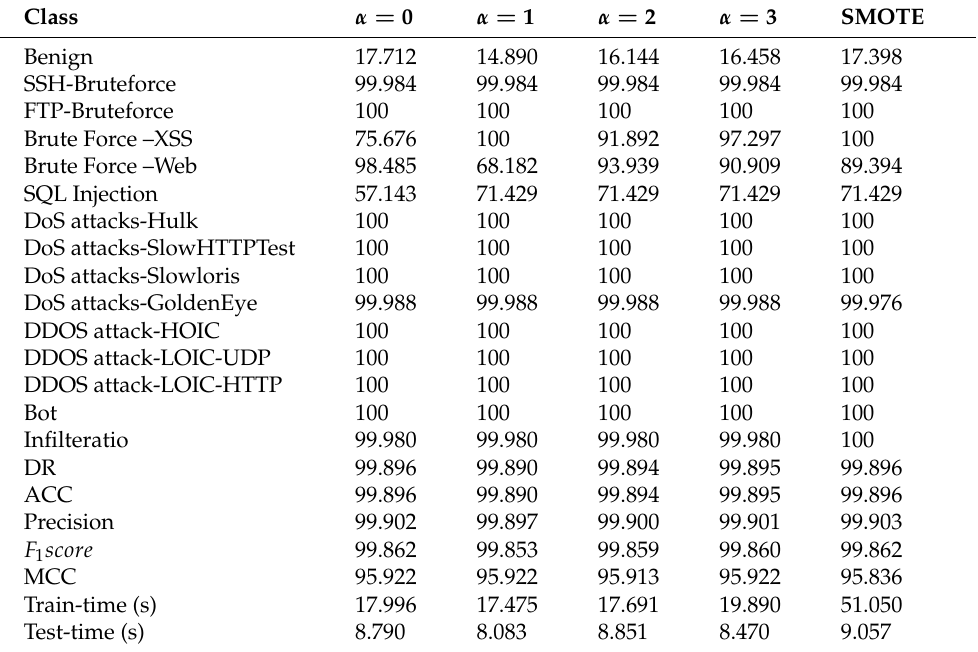
Table 6. Stage-2 CNN classification results when IR-SMOTE sets different degrees of oversampling coefficients